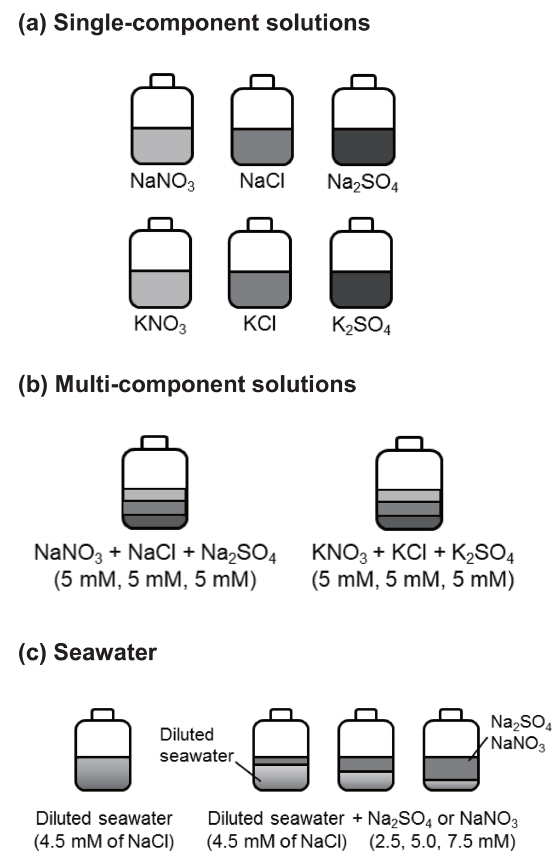
Figure 1. Summary of tested solutions. (a) Single-component so- lutions of NaNO 3 (SN), NaCl (SC), Na 2 SO 4 (SS), KNO 3 (PN), KCl (PC), and K 2 SO 4 (PS) with a molar concentration of 5mM. (b) Multi-component solutions of NaNO 3 + NaCl + Na 2 SO 4 and KNO 3 + KCl + K 2 SO 4 with a molar concentration of 5mM for each compound. (c) Diluted seawater (by a factor of 100; equivalent to 4.5mM of NaCl) and diluted seawater with Na 2 SO 4 or NaNO 3 with molar concentrations of 2.5, 5.0, and